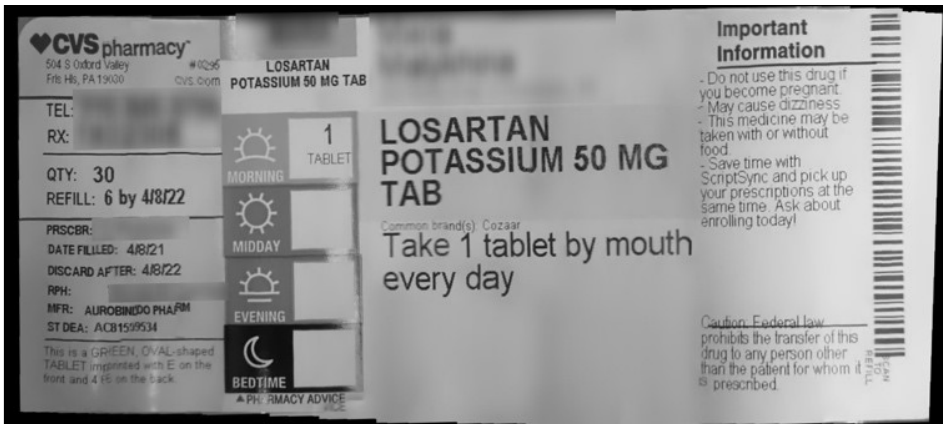
Figure 9. Alignment Result.